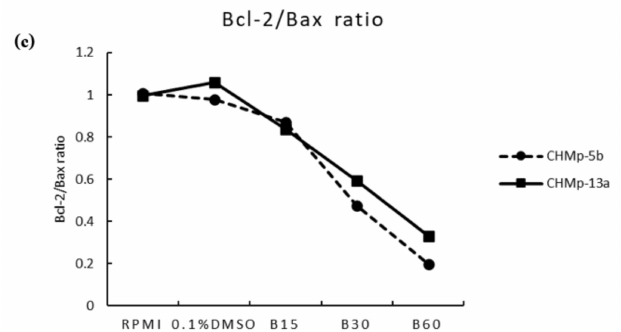
Figure 4. mRNA expression ratios of CHMp-5b and CHMp-13a cell lines in RPMI, 0.1% DMSO, BmKn-2 at 15, 30 and 60 µ g/mL: ( a ) The Bax mRNA expression ratios of CHMp-5b treated by adding BmKn-2 at 30 and 60 µ g/mL were significantly higher than control group, while the Bax mRNA expression ratios of CHMp-13a with BmKn-2 added at 60 µ g/mL was significantly different from the control; ( b ) The Bcl-2 mRNA expression ratios of CHMp-5b added with BmKn-2 at 30 and 60 µ g/mL were clearly significantly lower than control; CHMp-13a, the relative Bcl-2 mRNA expression ratios decreased significantly with BmKn-2 at 15, 30 and 60 µ g/mL; ( c ) Ratio of Bcl-2 to Bax where different letters on superscripts between plots representing the statistically significant differences ( p <